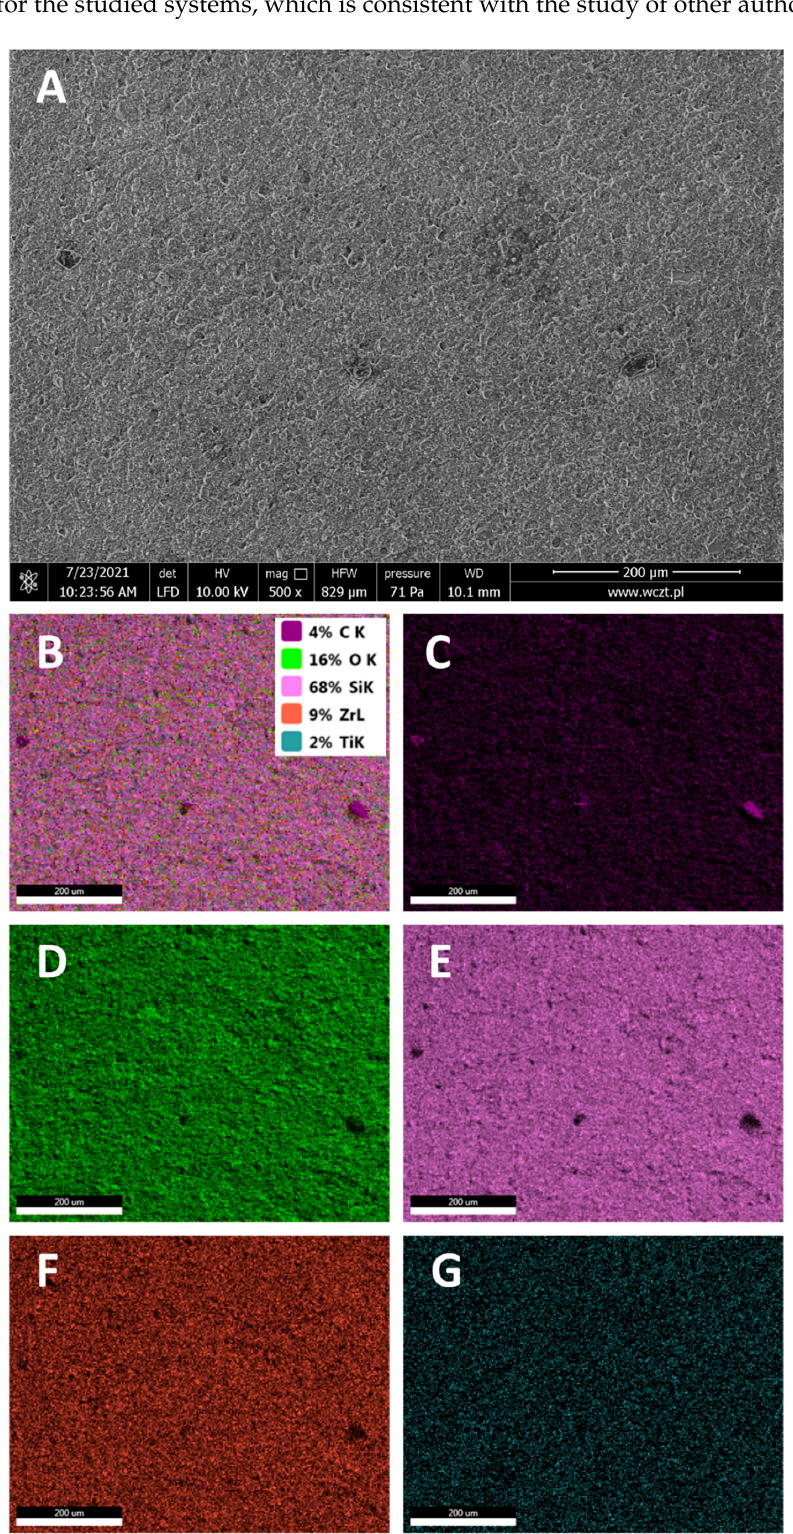
Figure 8. SEM ( A ) and EDS ( B – G ) images of the broken surface of neat composite. EDS maps show the presence of ( B )—all detected elements in wt%, ( C )—carbon; ( D )—oxygen; ( E )—silicon; ( F )—zirconium; ( G